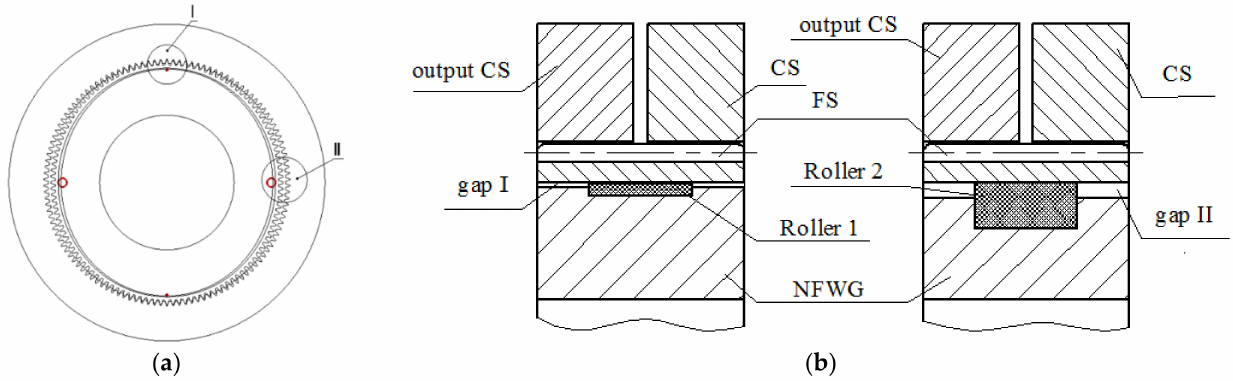
Figure 12. ( a ) Design diagram. ( b ) partial enlarged schematic diagram at major axis of the NFWG I and minor axis of the NFWG